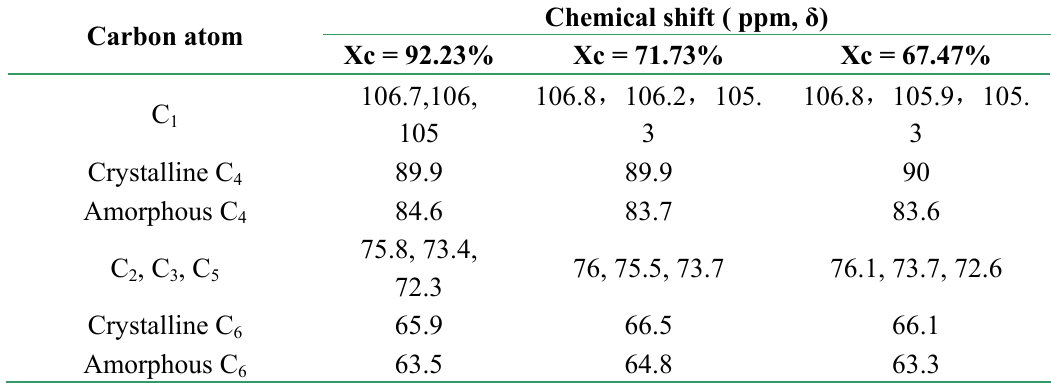
Table 1. Resonance assignments for the CP/MAS 13 C NMR spectra of cellulose and cellulose treated using phosphoric